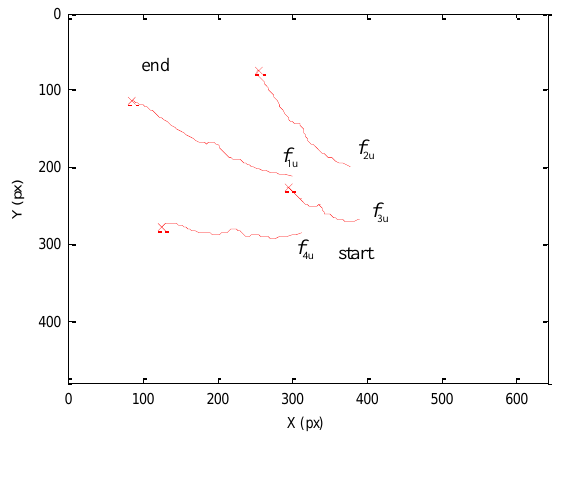
Figure 7. Image trajectory described by the robotic manipulator using the RVC.